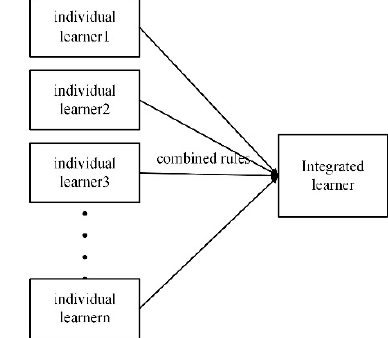
Figure 1. Research area — Beijing, China